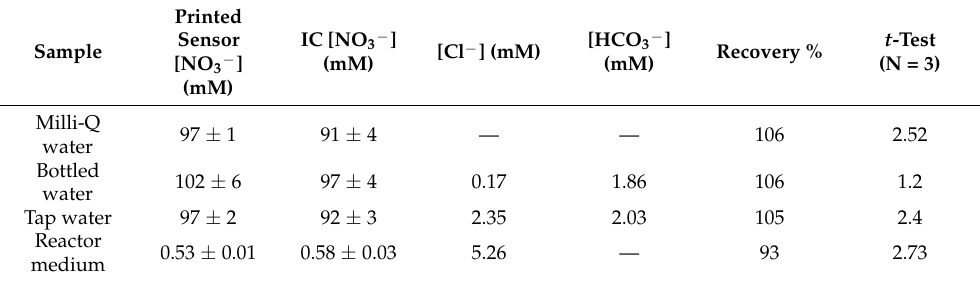
Table 3. Sensor validation comparing the results of different spiked and real samples measured with the integrated RE and NO 3 − sensor platform (N = 3) and IC. Cl − and HCO 3 − concentrations are included to compensate using the potentiometric